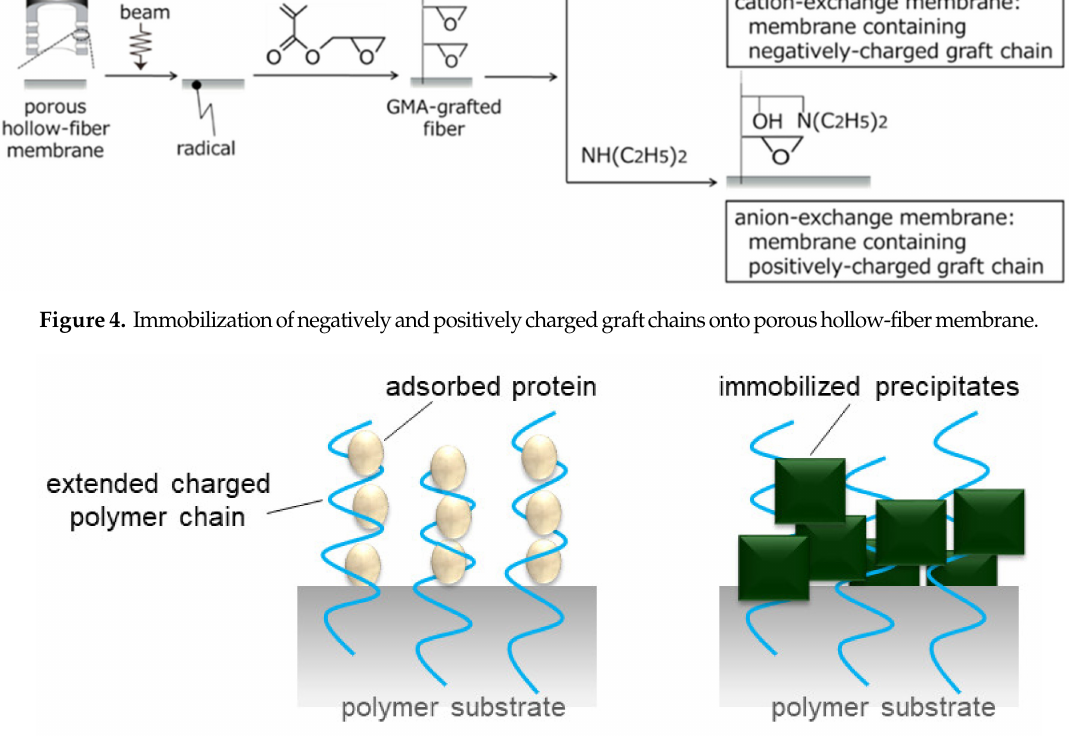
Figure 5. Protein multilayer adsorption and inorganic-precipitate immobilization to the extended charged polymer